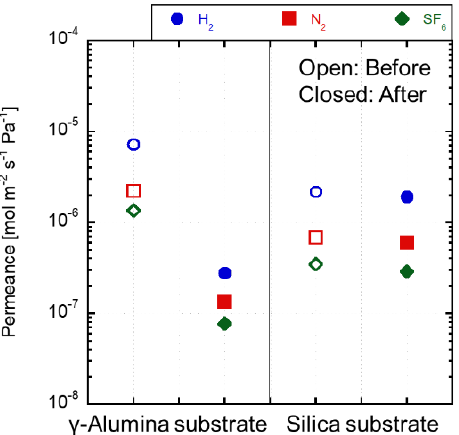
Figure 8. Gas permeance change of each substrate of 1 mol L − 1 H 2 SO 4 immersion before and after 24 h.